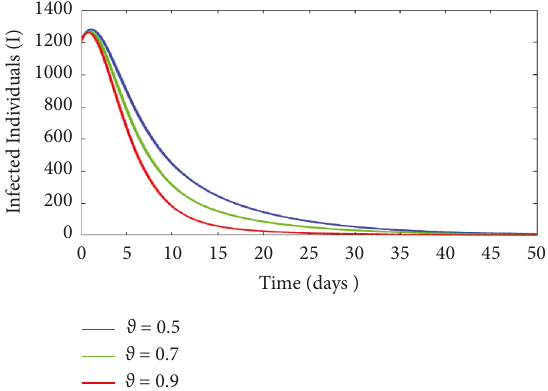
Figure 2: The effect of variation in vaccine efficacy ( ϑ ) on infection dynamics.